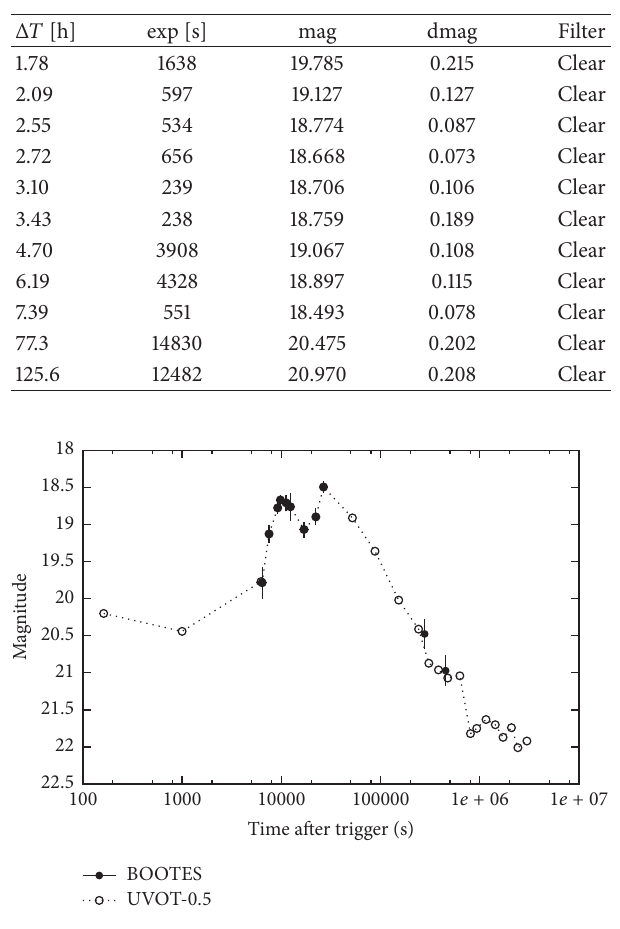
Figure 7: The bizarre optical light curve of GRB 100418A. Combi- nation of BOOTES and UVOT data [45]. UVOT points were shifted by an arbitrary